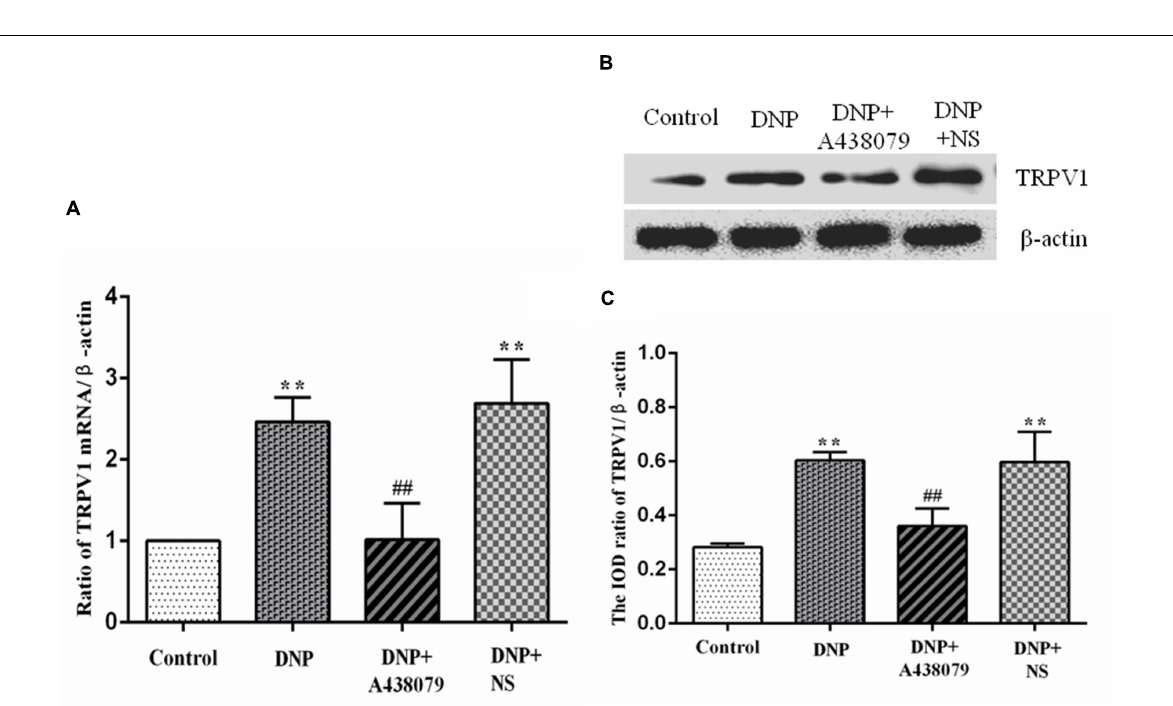
Frontiers in Molecular Neuroscience |